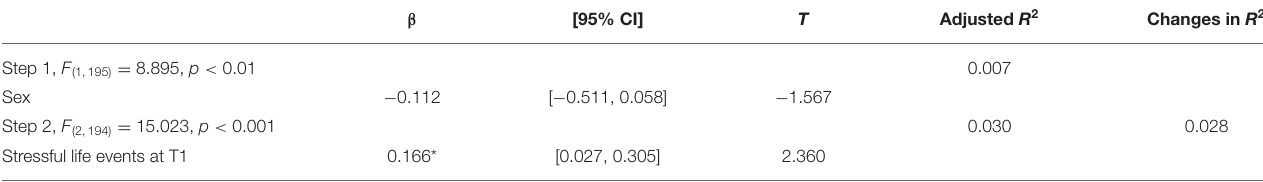
TABLE 3 | Hierarchical regression analyses predicting PSU at